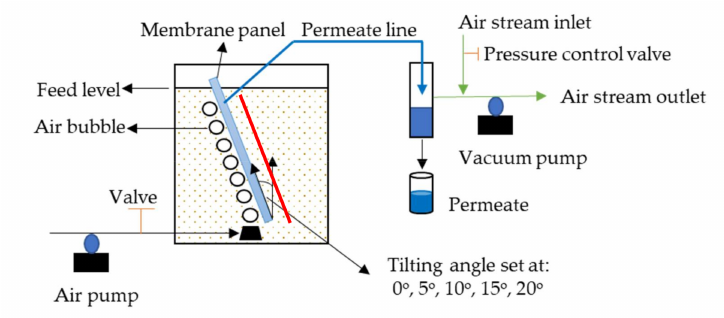
Figure 1. Experimental setup for laundry wastewater filtration using tilted panel system. The red line on the left side of the filtration panel indicates the membrane sheet fixed on the